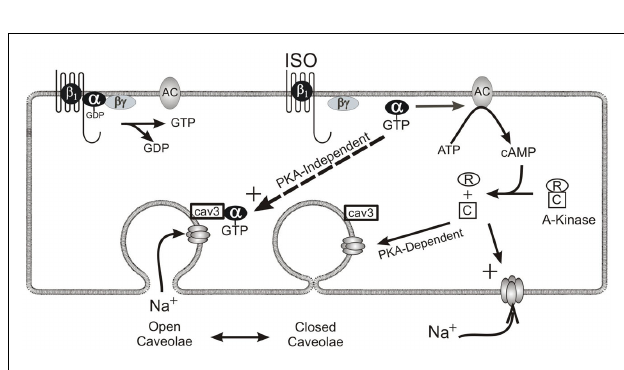
FIGURE 1 | Electron micrograph of an adult rat ventricular myocyte showing caveolae (arrow in inset) around the perimeter. Caveolae are typically spherical in shape with a diameter of approximately 50–100nm and can accumulate in a clustered structure around a common neck.